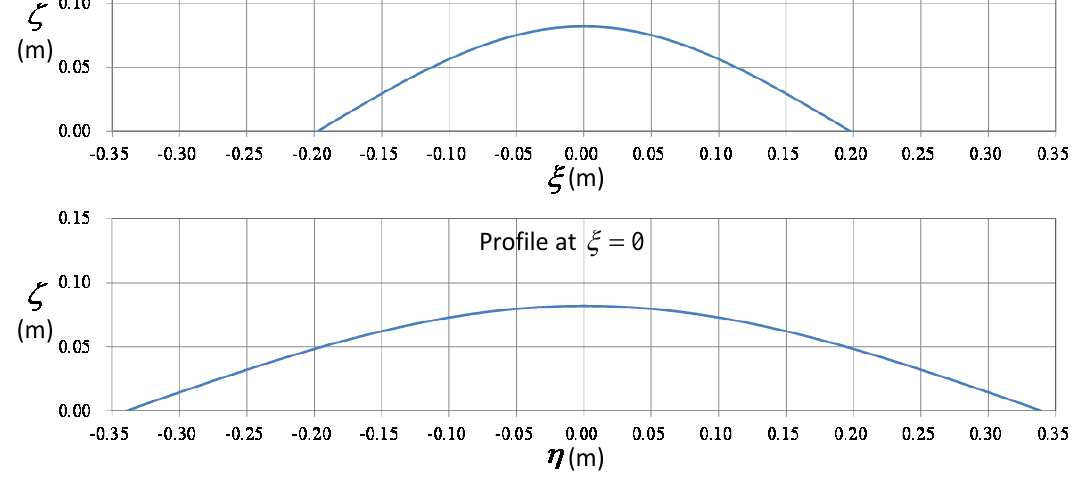
Figure 3. The geometry of the landslide model.